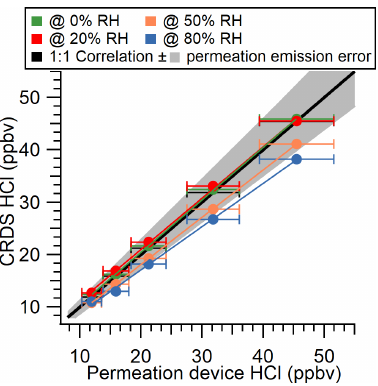
Figure 2. Comparison of CRDS HCl measurements and output from an HCl permeation device over a range of RHs. Error bars in the x direction represent propagated IC measurement error, while error bars in the y direction represent the standard deviation of the online sampling plateau for each mixing ratio (low magnitudes mean these error bars do not extend beyond the points). A 1:1 cor- relation (solid black line) is shown with the uncertainty in the per- meation device emission rate (shaded grey area).